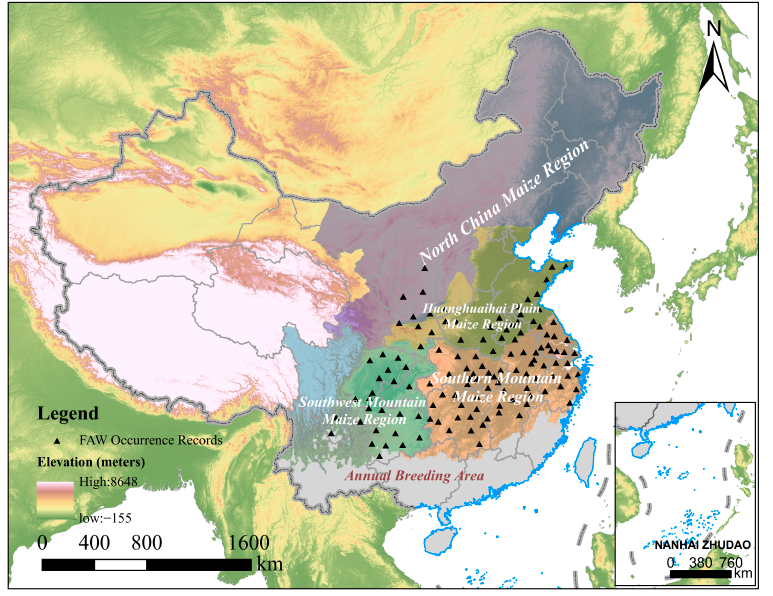
Figure 1. The geographical location of the study area and FAW occurrence records. The gray area represents the annual breeding area, i.e. the area where the average temperature of the coldest month (January) is greater than 10 °C and FAW and host plants can grow here year-round [22] ; the Digital Elevation Model (DEM) available from USGS [37]; and the shapefile of four major maize growing regions in China available from http://region.agridata.cn/ (accessed on 16 February 2022).